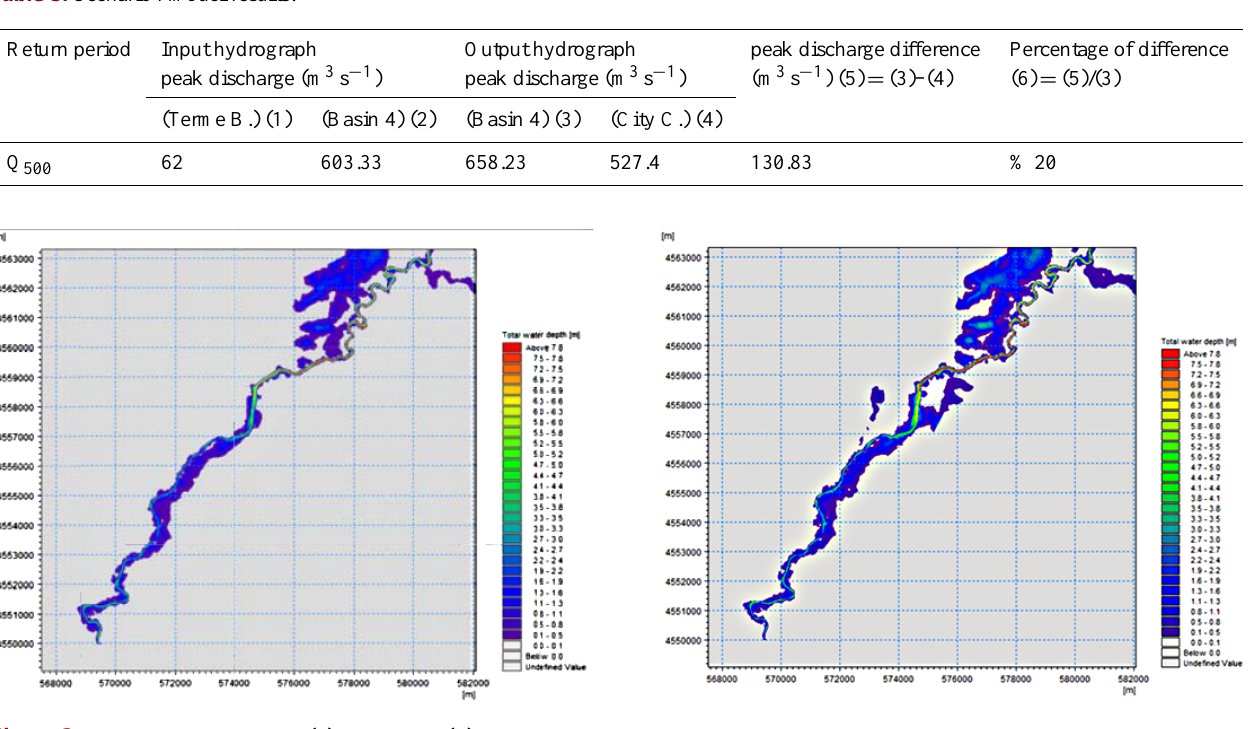
City and Fig. 3b shows the water spreading out of the river bed after Basin 4 connection is